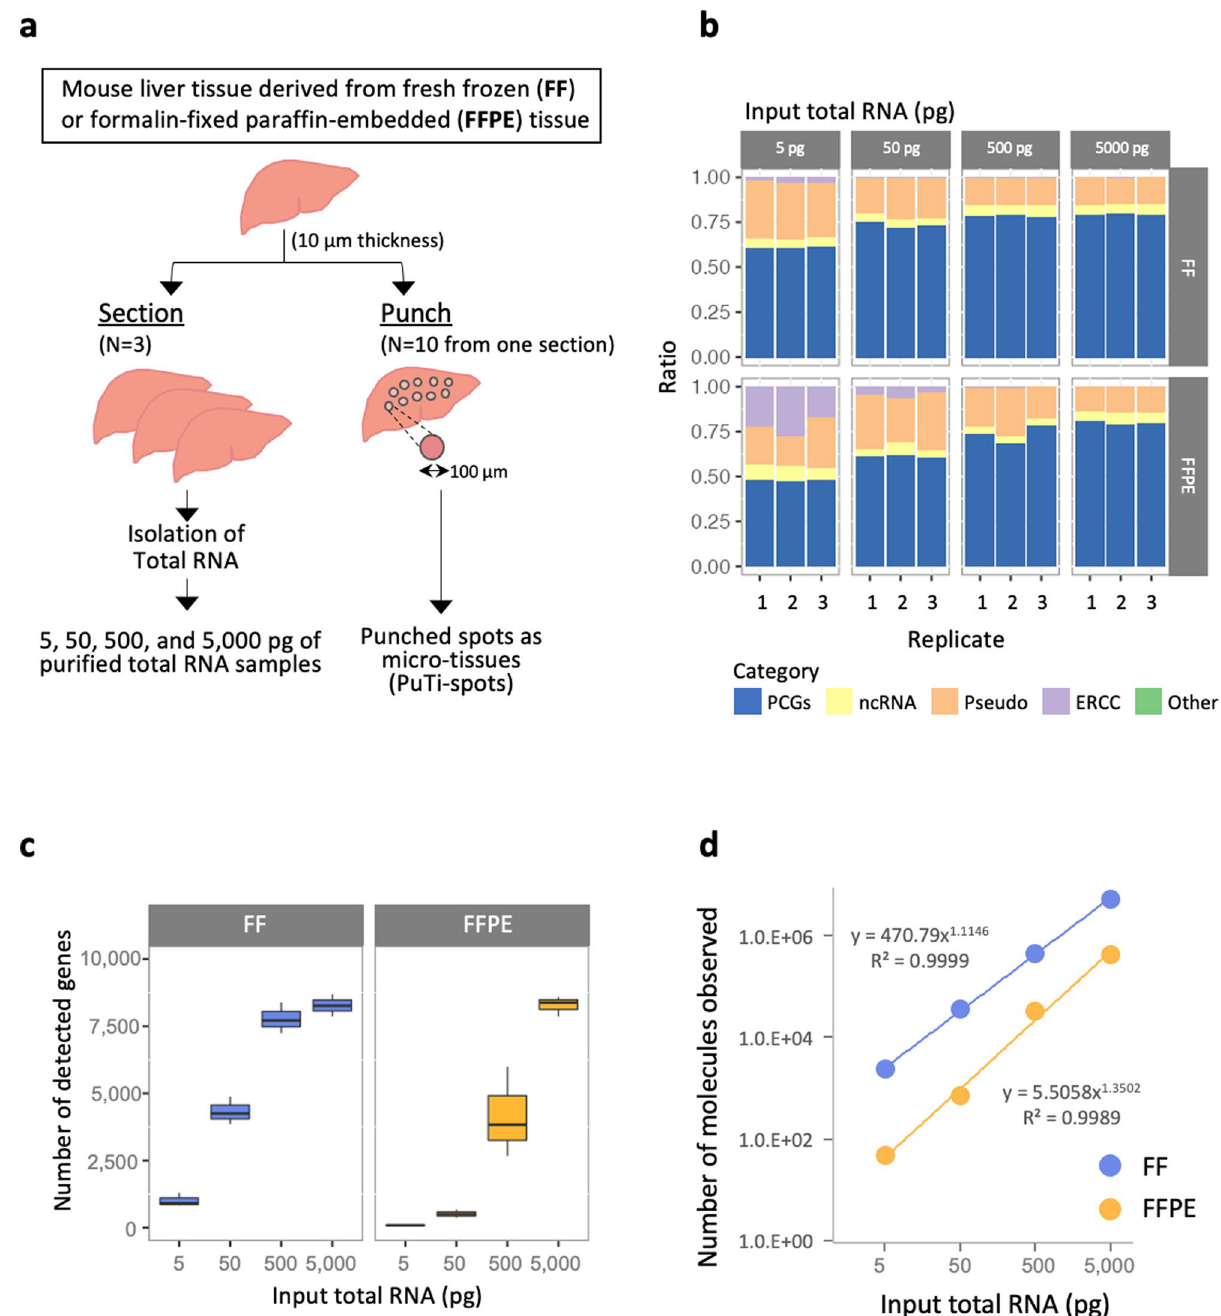
Figure 1. Evaluation of RNA-seq profiling of purified total RNA derived from FFPE and FF tissues. ( a ) Overview of sample preparation for evaluation using mouse liver tissue. Purified total RNA samples were prepared using the RNeasy Mini Kit (QIAGEN) for FF tissues or RNeasy FFPE Kit (QIAGEN) for FFPE tissues. Three adjacent tissue slices (thickness: 10 μm) were used as section-replicates (N = 3) and 10 PuTi-spots (φ = 100 μm) collected from a single tissue section were used as punch-replicates (N = 10). ( b ) Mapping category of reads. We evaluated whether reads were assigned to five categories: PCGs, ncRNAs, pseudo genes, ERCC of internal standard RNAs, or others. As the input increased, the ratio assigned to the PCGs increased, and above a certain quantity, the values were saturated. It is also apparent that the assignment of reads to ERCC increases when PCGs have fewer reads, starting at 5 or 50 pg. ( c ) Number of detected genes. The number of genes detected for respective input RNAs was plotted. Libraries were prepared using total RNA purified from FF or FFPE tissue sections (N = 3) as the starting material. PCGs were identified from the respective libraries. ( d ) Number of RNA molecules from total RNA contributing to the reaction. We estimated the number of RNA molecules that contribute to the reaction with reference to ERCC, which was used as an internal standard, that is, the value of (sum of TPMs of the RNA) × (sum of the number of molecules of the input ERCC)/(sum of TPMs of the ERCC) = (sum of the number of input RNA molecules) was plotted. FFPE formalin-fixed paraffin-embedded, FF fresh frozen, RNA-seq RNA-sequencing, PCGs protein-coding genes, ncRNAs non-coding RNAs, TPM transcripts per kilobase